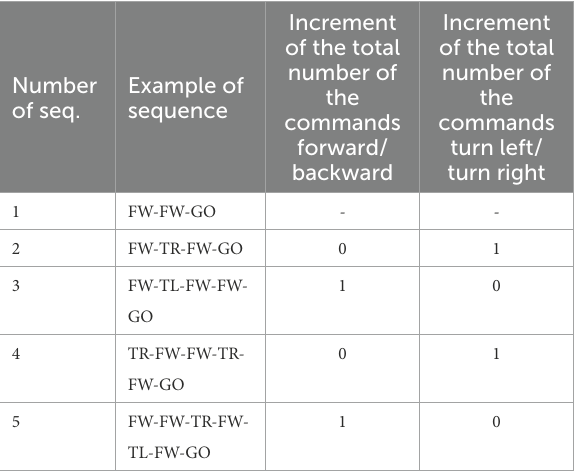
TABLE 3 Complex sequences of